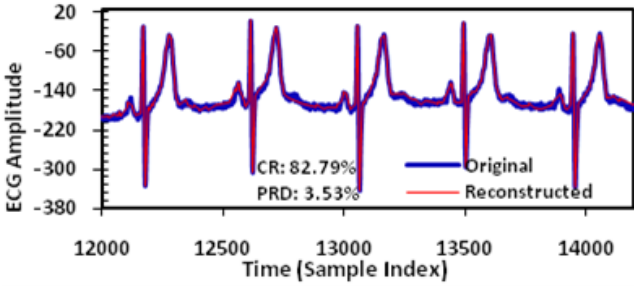
Figure 8. Original and reconstructed ECG signal (No. 117 record).